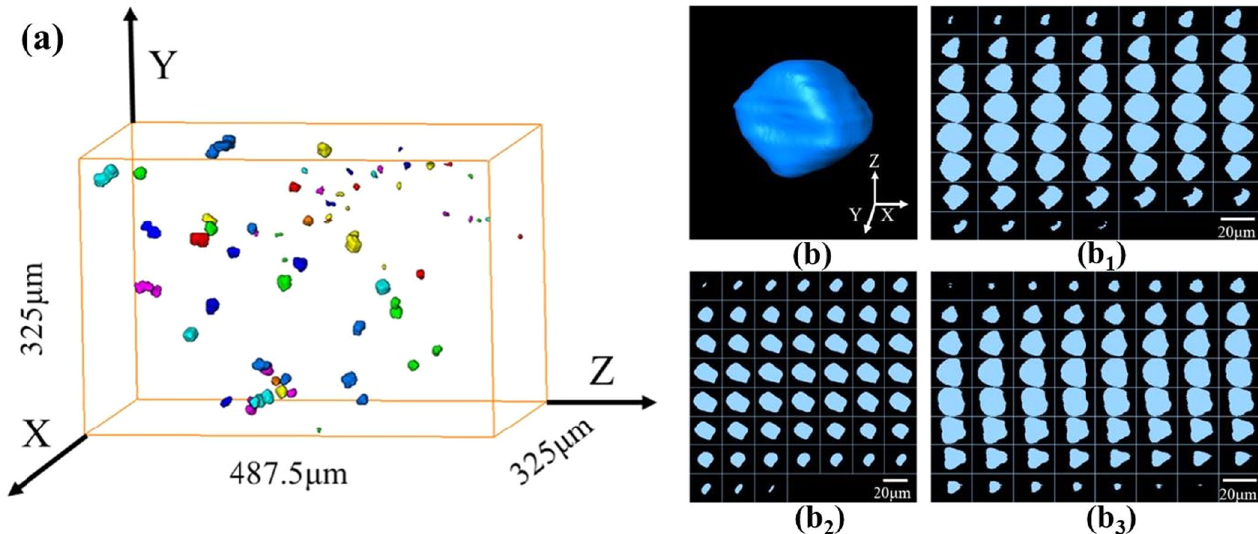
Fig. 5 Three-dimensional spatial distribution and pro fi le morphology of TiN inclusions. a Spatial distribution of TiN inclusions in a space of around 0.051 cm 3 in steel after three-dimensional reconstruction. b A typical three-dimensional morphology of a single TiN particle and its corresponding two-dimensional computed tomography slices in b 1 X direction, b 2 Y direction, and b 3 Z direction, respectively 60